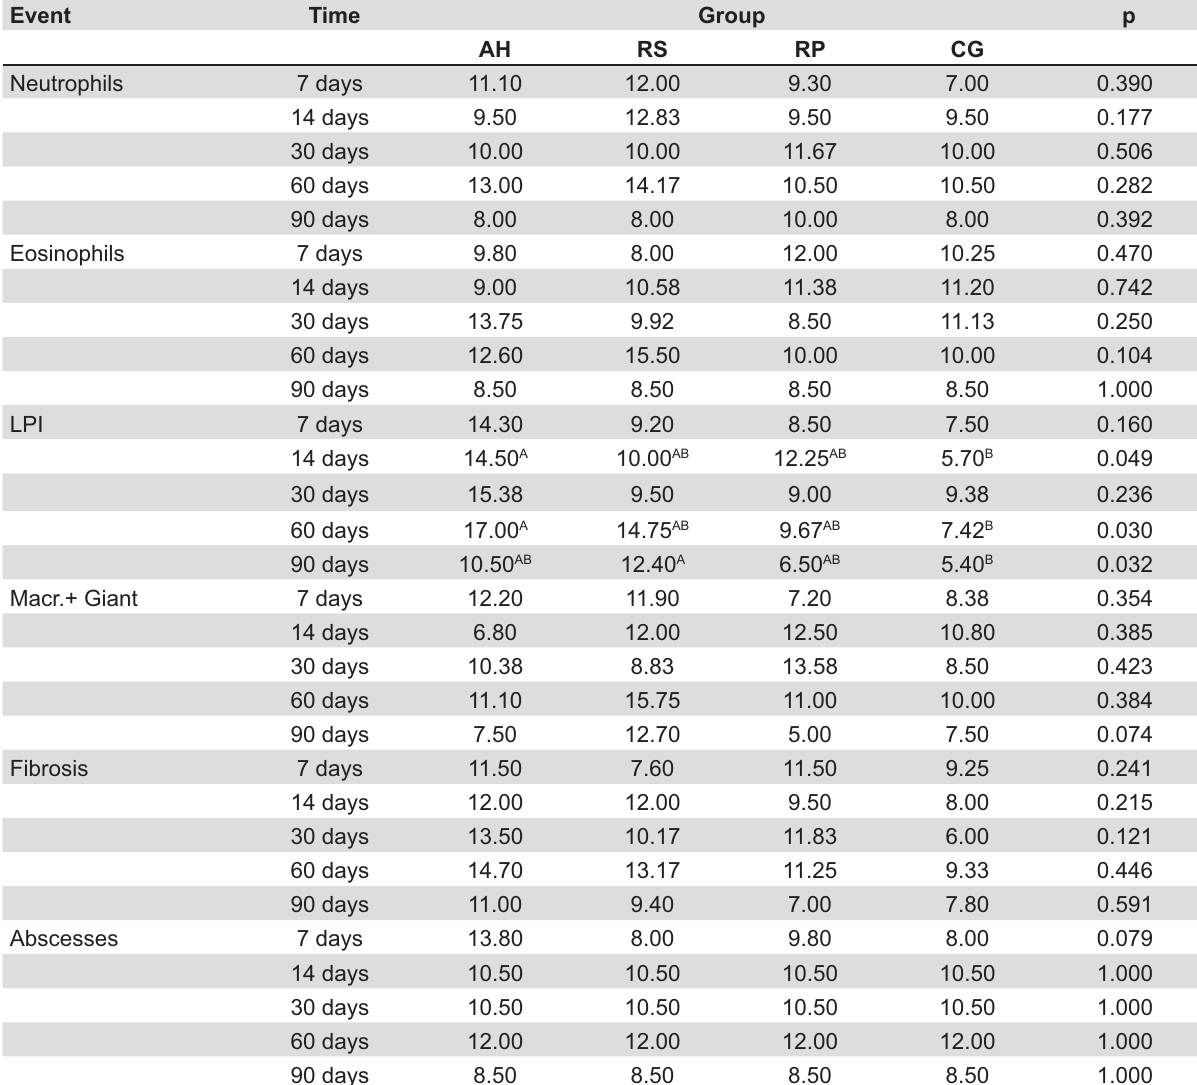
Table 1- Mean scores attributed to the AH Plus Sealer (AH), RealSeal Sealer (RS), RealSeal Primer (RP), and Control (CG) groups, after experimental periods of 7, 14, 30, 60 and 90 days, for the six events